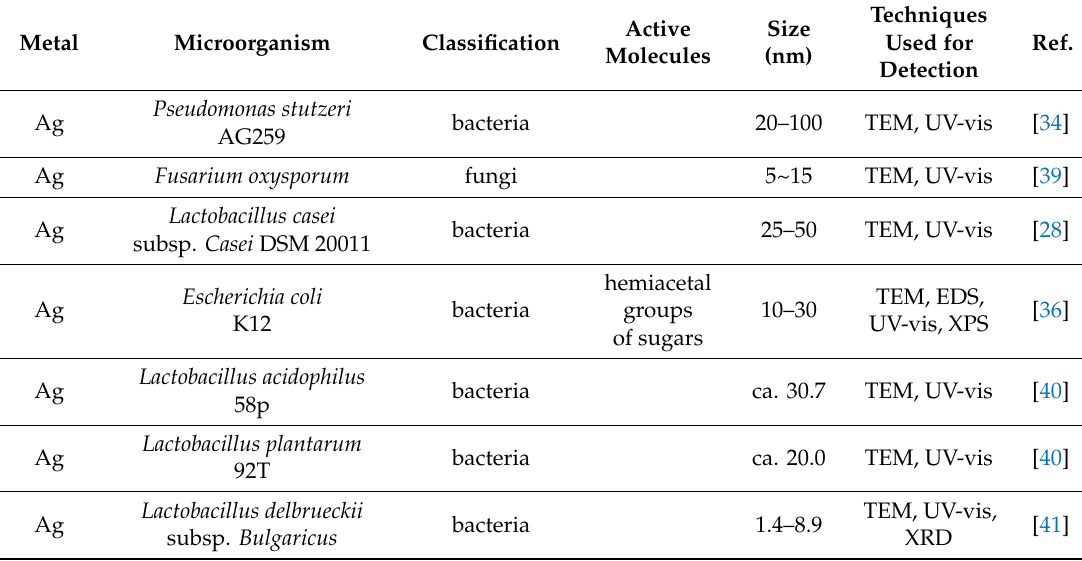
Table 1. List of microorganisms for synthesis of Ag nanoparticles and technique for confirmation of Ag